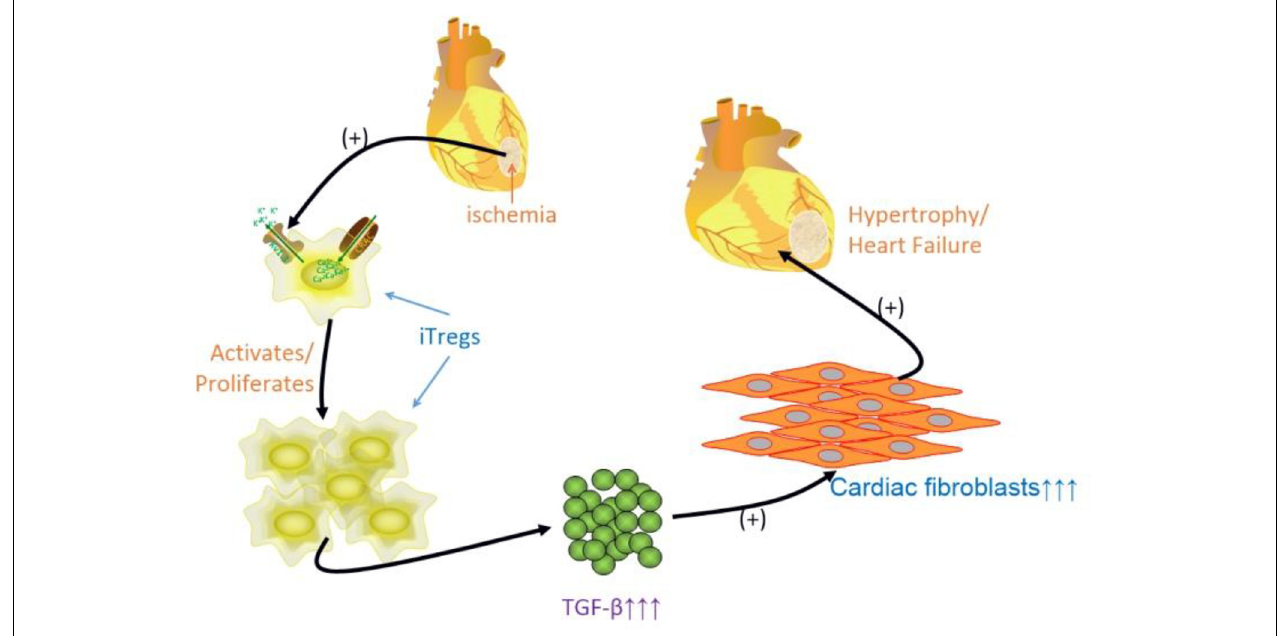
FIGURE 9 | Schematic graph of the idea of the article. Some inflammatory states of heart disease, i.e., ischemia, atherosclerosis, myocardial infarction, late stage of CHF, and etc., activate immuno-response, induced regulatory T lymphocytes (iTregs) is activated/proliferated by activating Kv1.3 channels to assist Ca 2 + influx, and releasing much more TGF- β (less IL-10 relatively), which multiplies cardiac fibroblasts leading to cardiac fibrosis to process the hypertrophy, even to heart